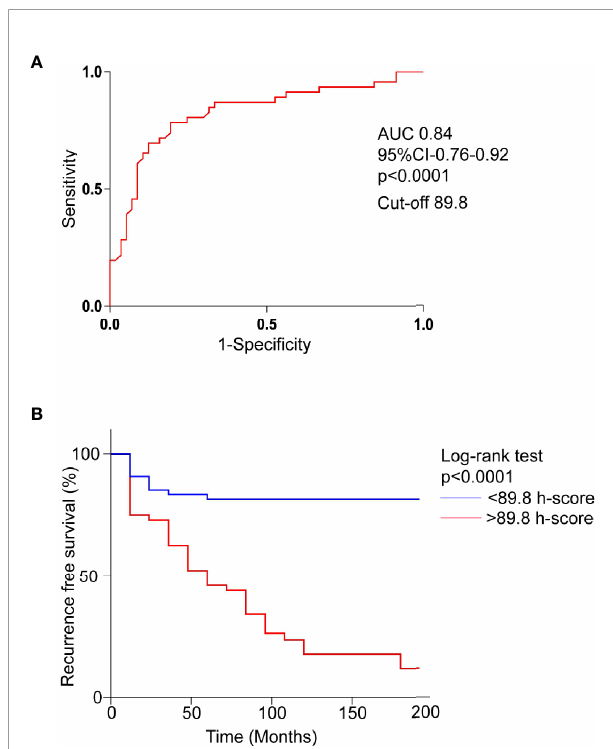
FIGURE 3 | Overexpression of pEGFR T693 as an independent prognostic factor of recurrence in NFPAs. (A) Receptor operating characteristics curve (ROC) for prediction of recurrence based on pEGFR T693 h-score showed an h-score cutoff of 89.8 (80% sensitivity, 78% speci fi city) and an area under curve of 0.84 (p < 0.0001) indicating pEGFR T693 as a good biomarker of recurrence (B) Kaplan – Meier recurrence-free survival of the patients after surgery for NFPAs (n=102) strati fi ed according to the cut-off level of h-score 89.8. High levels of pEGFR T693 as an independent predictor of recurrence (p < 0.0001). The red line indicates patients with an h-score higher than 89.8 and the blue line indicates an h-score less than 89.8.